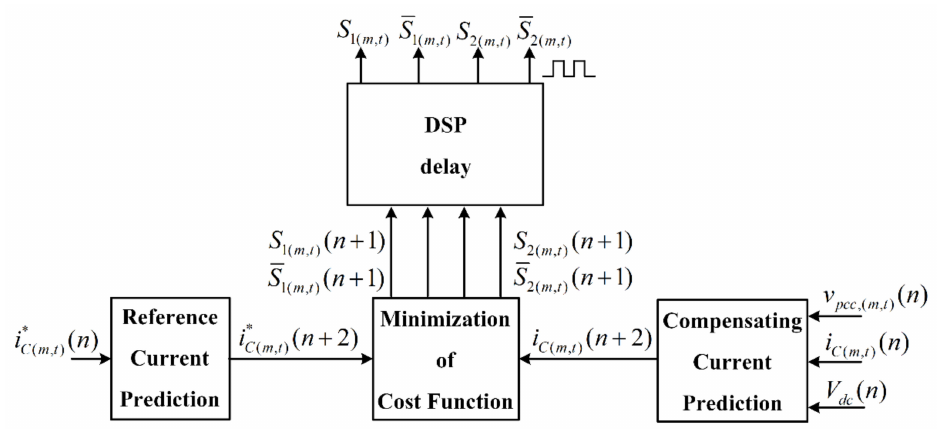
Figure 3. The model predictive control for compensating current control system. DSP: digital signal